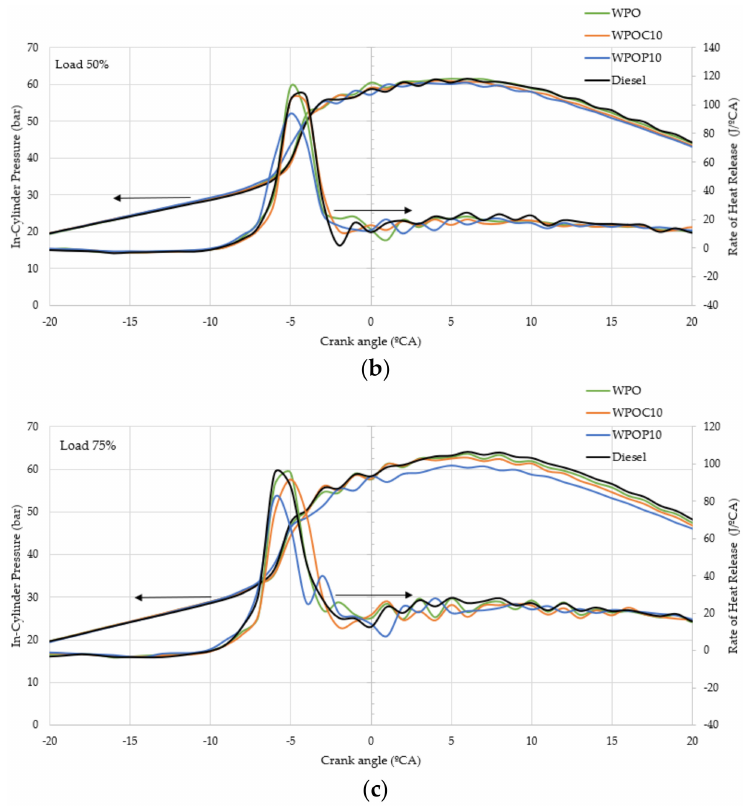
Figure 7. In-cylinder pressure and rate of heat release at di ff erent levels of maximum torque: ( a ) 25%; ( b ) 50%; ( c )